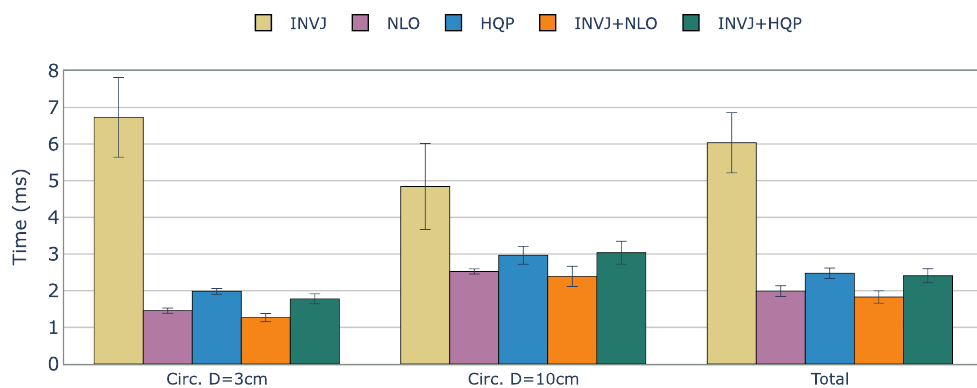
Figure 7. Average runtime (ms) of successful IK solves for a constrained tracking task with KC-2 (OpenRST) kinematic chain. The concurrent solvers demonstrated slightly better performance than their respective optimization-based single-method IK solvers, with INVJ showing the worst time performance due to its low solve rate.